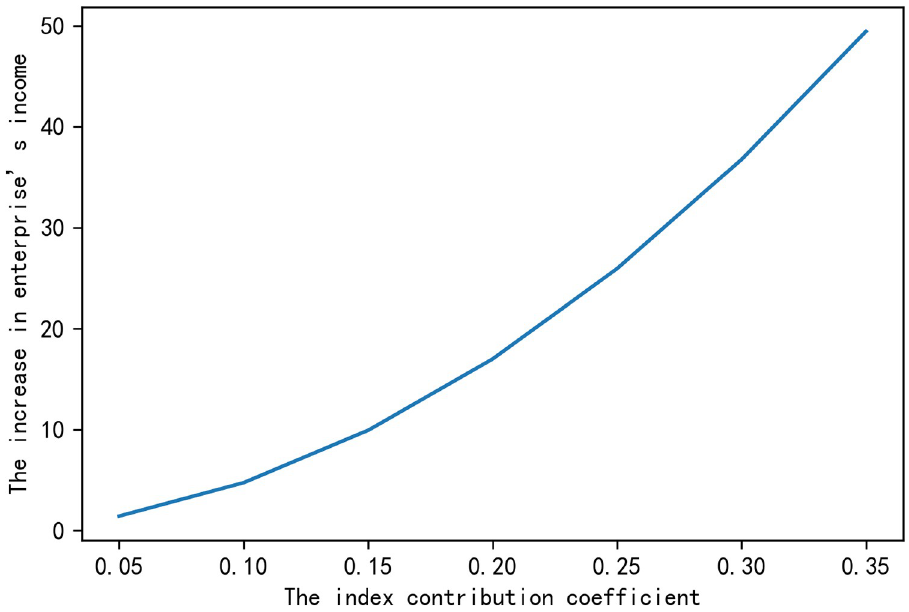
Fig 2. The impact of the index contribution coefficient on the increase in enterprise’s